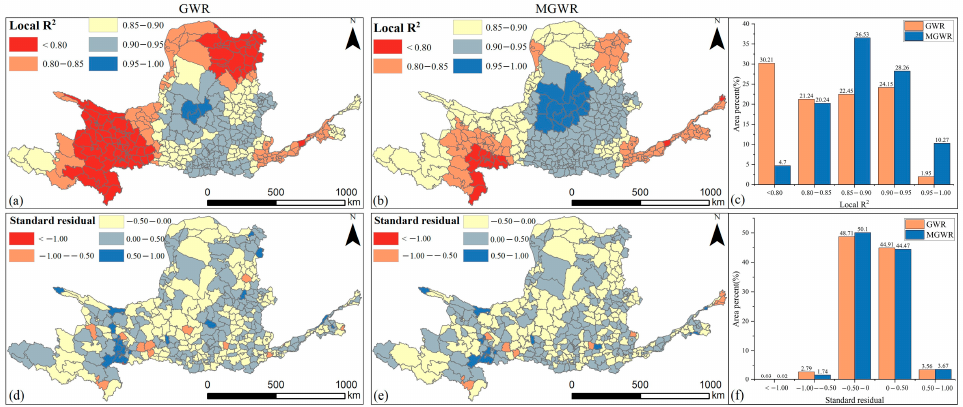
Figure 4. Spatial distribution and area percent of Local R 2 ( a – c ) & Standard residual ( d – f ) from GWR and MGWR.